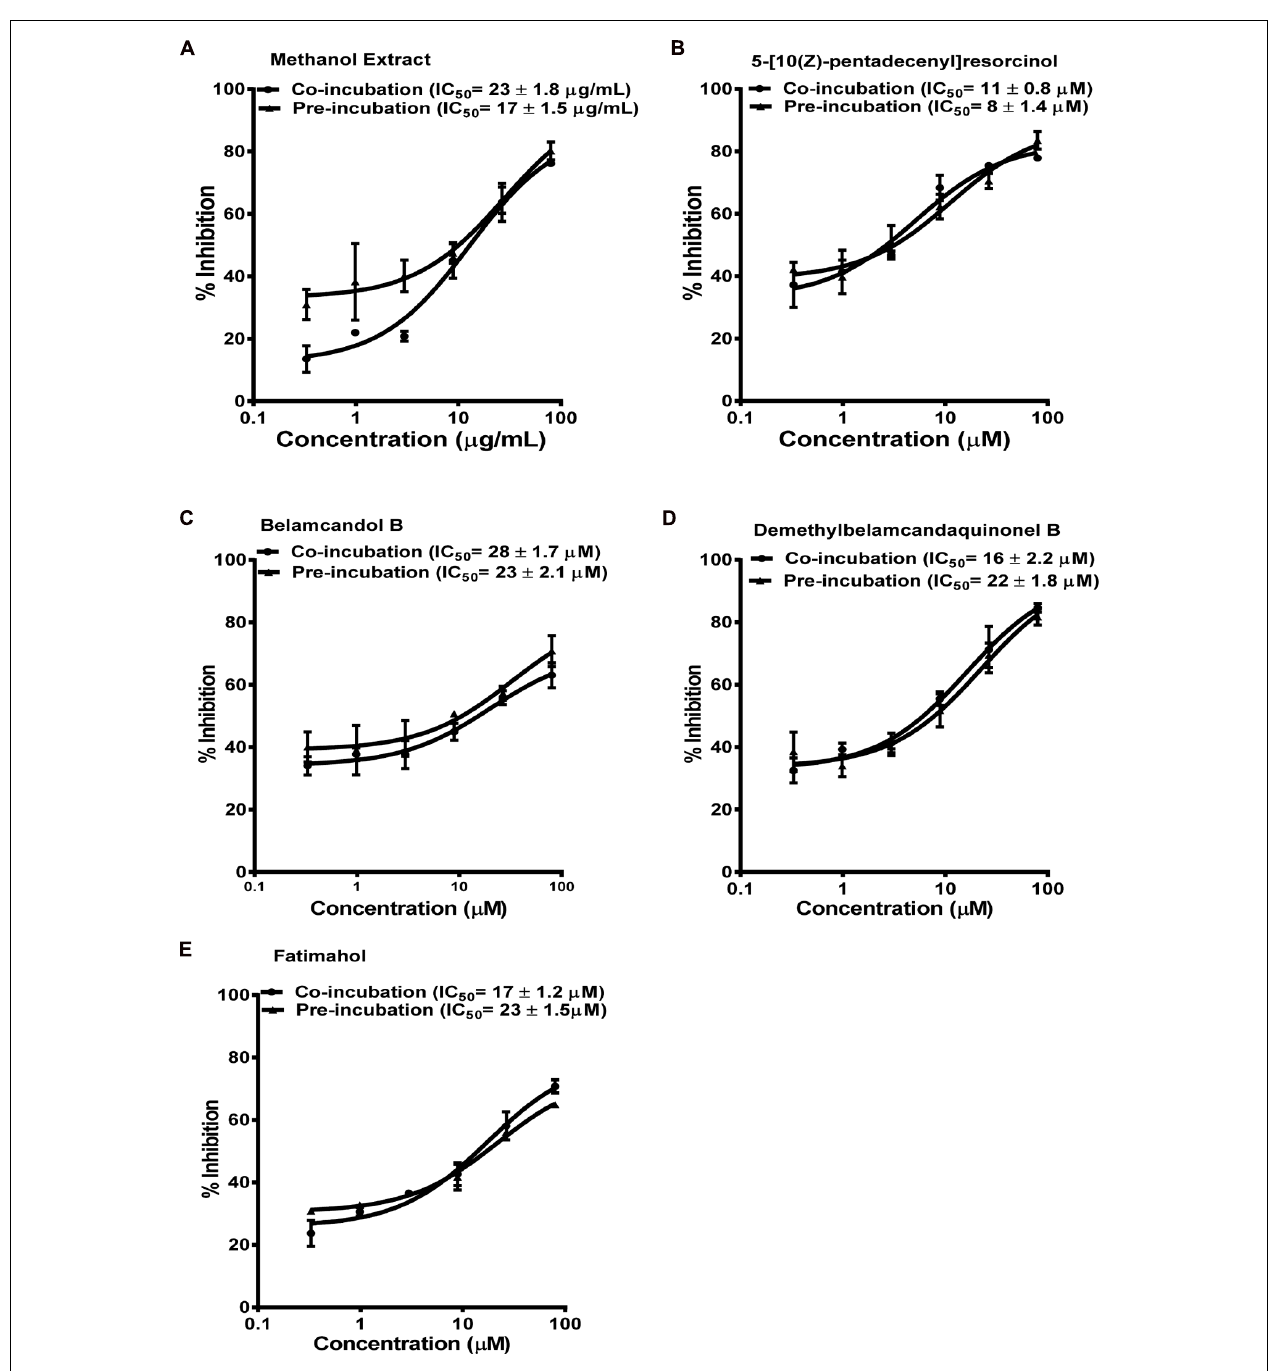
FIGURE 3 | Dose response profiles of reversible andTDI of CYP2C9 enzyme by Labisia pumila root extract (A) and its alkyl phenolic constituents (B–E). The data are represented as mean ± SD of 3 independent experiments ( n = 2 in each experiment).